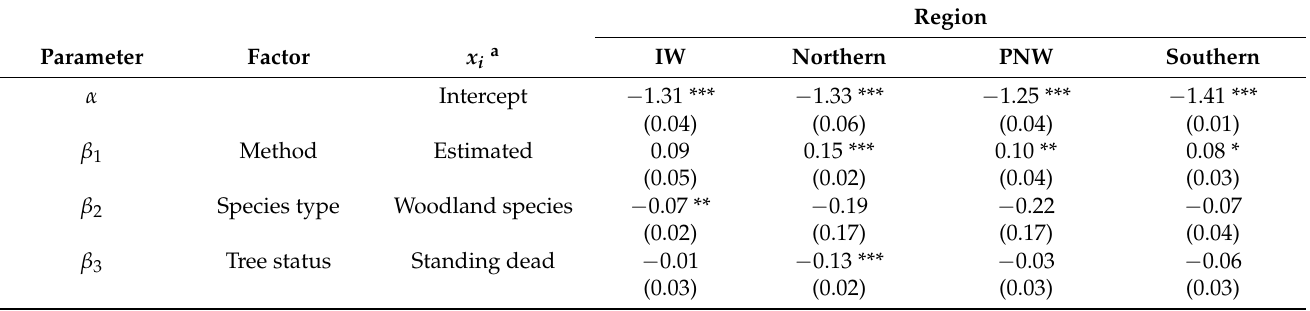
Table 4. Estimated coefficients (and standard errors) for the model logit ( π ) = α + β 1 x 1 + β 2 x 2 + · · · + β 5 x 5 predicting the probability that actual height ends with the digit 0 or 5 by